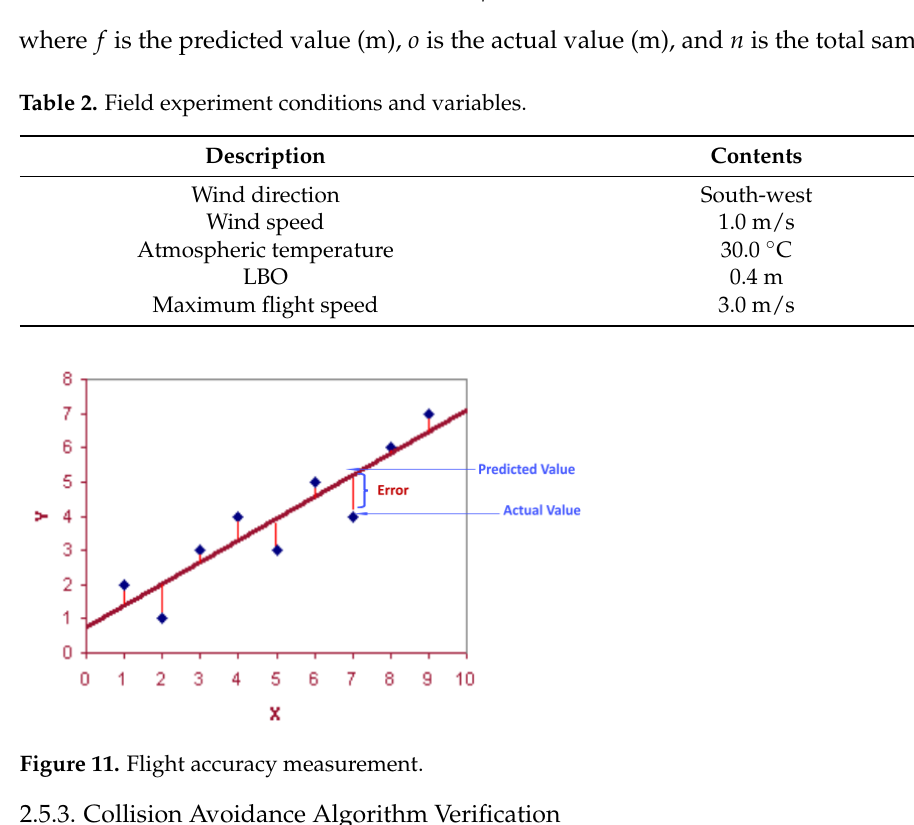
Figure 10. A configuration diagram of the long-distance wireless communication latency experi- ment.